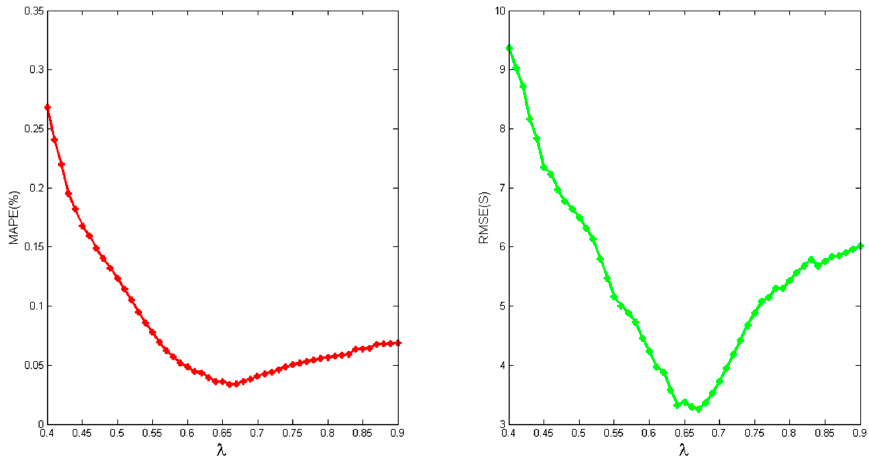
Figure 6. Accuracy with different value of λ .